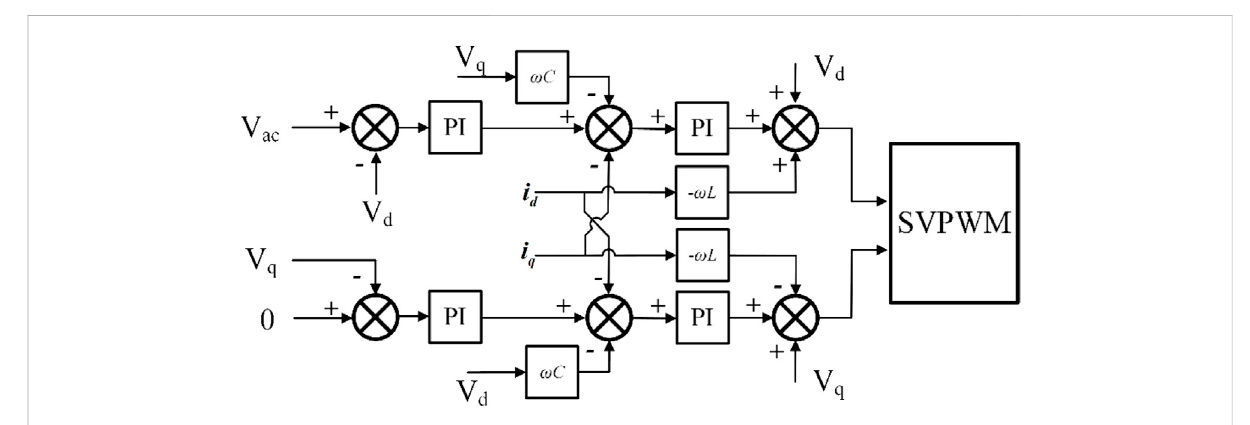
FIGURE 7 Schematic diagram of Vf control